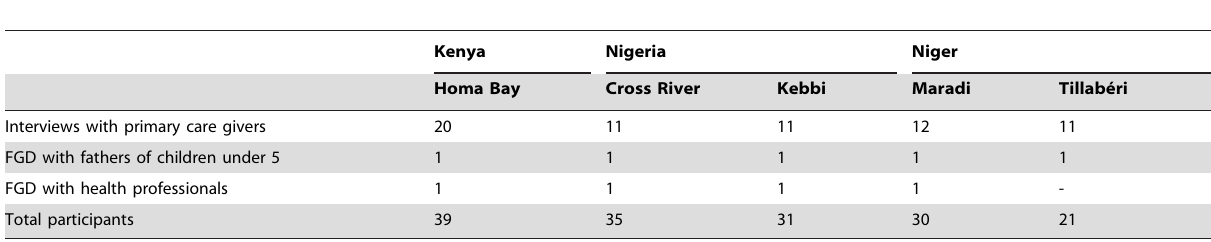
Table 2. Overview of participants per data collection method in each study